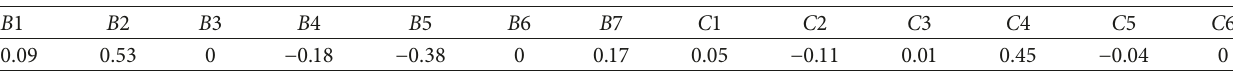
Table 1: The area average of related to Nino 3 index 850hPa regression anomaly of B 1– B 7 and C 1– C 6 over SEC (unit: 10 − 19 m